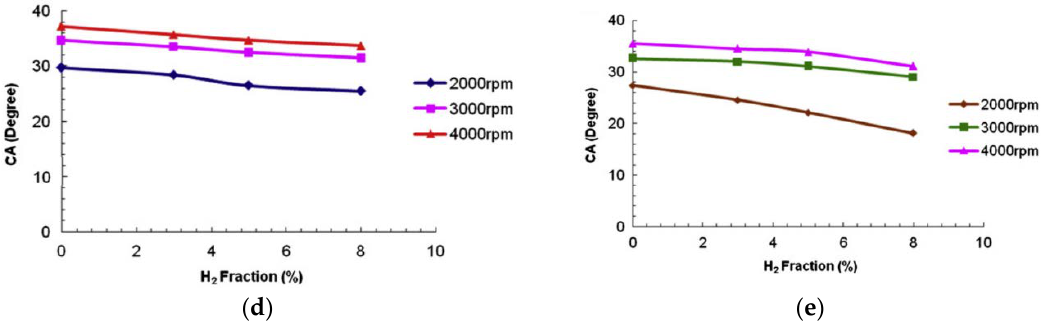
Figure 21. Effect of adding a small fraction of hydrogen on the performance and combustion of a CNG SI engine. ( a ) Brake torque versus engine speed; ( b ) brake thermal efficiency (BTE) versus engine speed; ( c ) in-cylinder pressure versus crank angle for various hydrogen-blending ratios; ( d ) flame-development duration versus H 2 percentage; ( e ) rapid-combustion duration versus H 2 percentage [233].